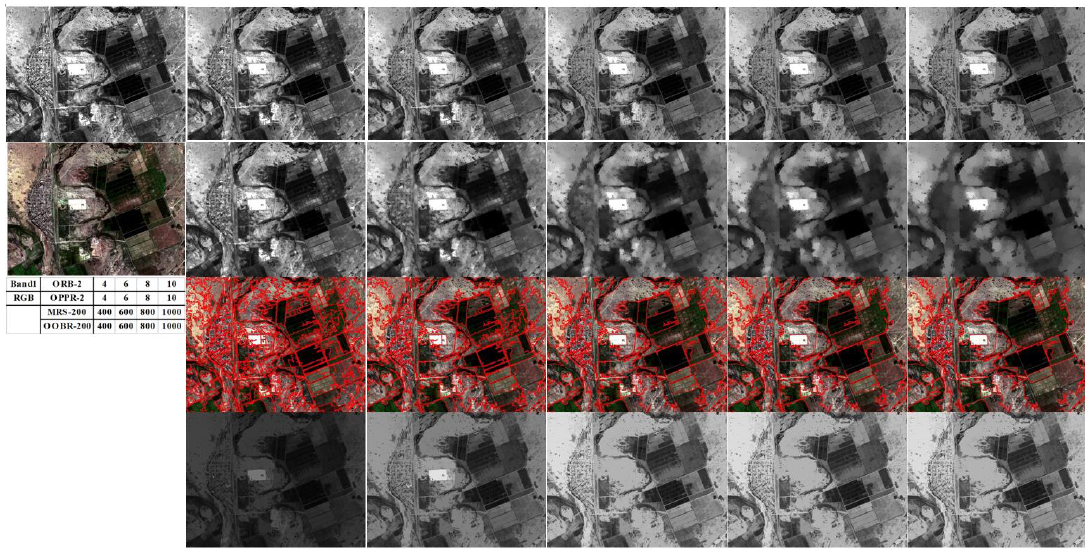
Figure 5. Examples of OBR (row 1), opening by partial reconstruction (OBPR) (row 2), multi-resolution segmentation (MRS) segments (row 3), object-guided OBR (OOBR) (row 4) computed from band 1 (first image at row 1) at the center-bottom of Figure 1f (the numbers in the table in row 3 show the disk sizes in OBR and OBPR and the segmentation scale λ in MRS).